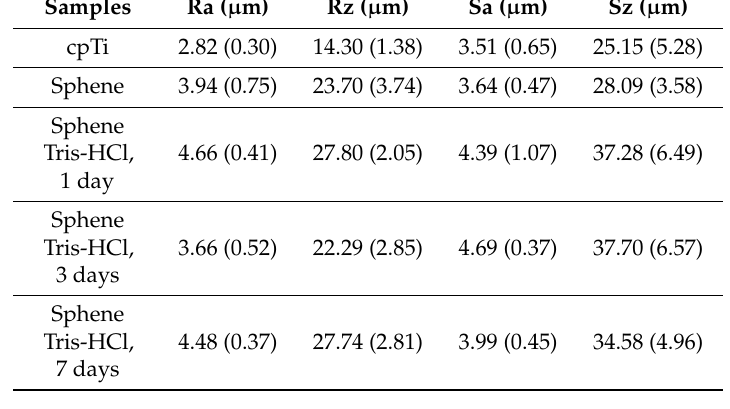
Table 1. Linear and surface roughness of as-received cpTi, sphene-coated cpTi, and sphene-coated cpTi after 1 and 7 days of chemical etching in Tris-HCl. Values are expressed as mean (standard deviation).